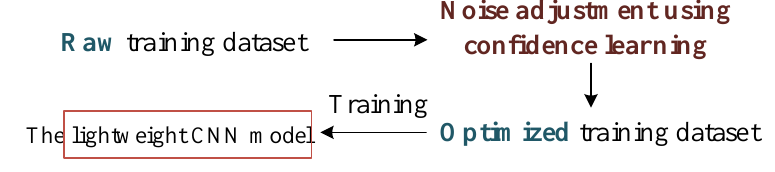
Figure 2. The Idea of the